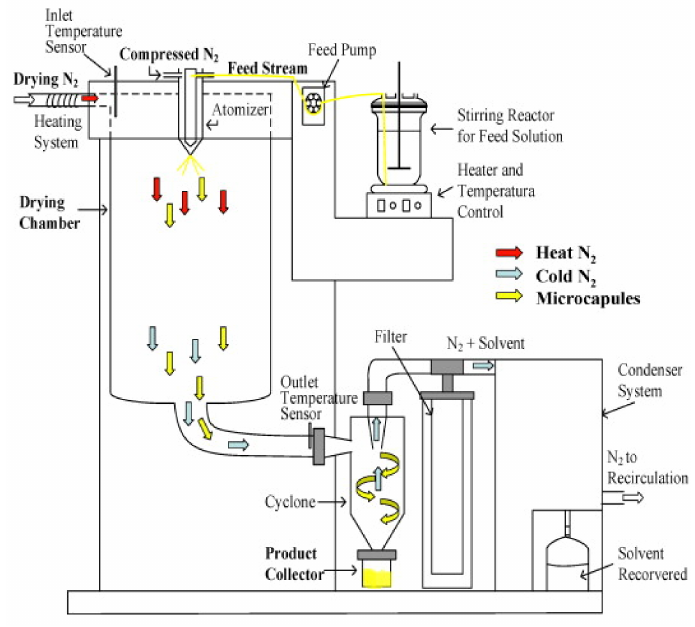
Figure 8. Schematic representation of the principle of spray-drying process [139].